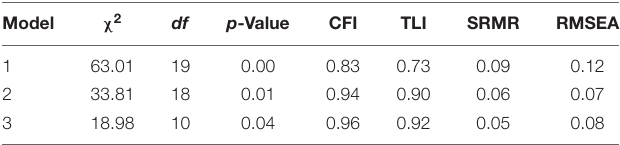
TABLE 3 | Fit statistics of the path and alternative